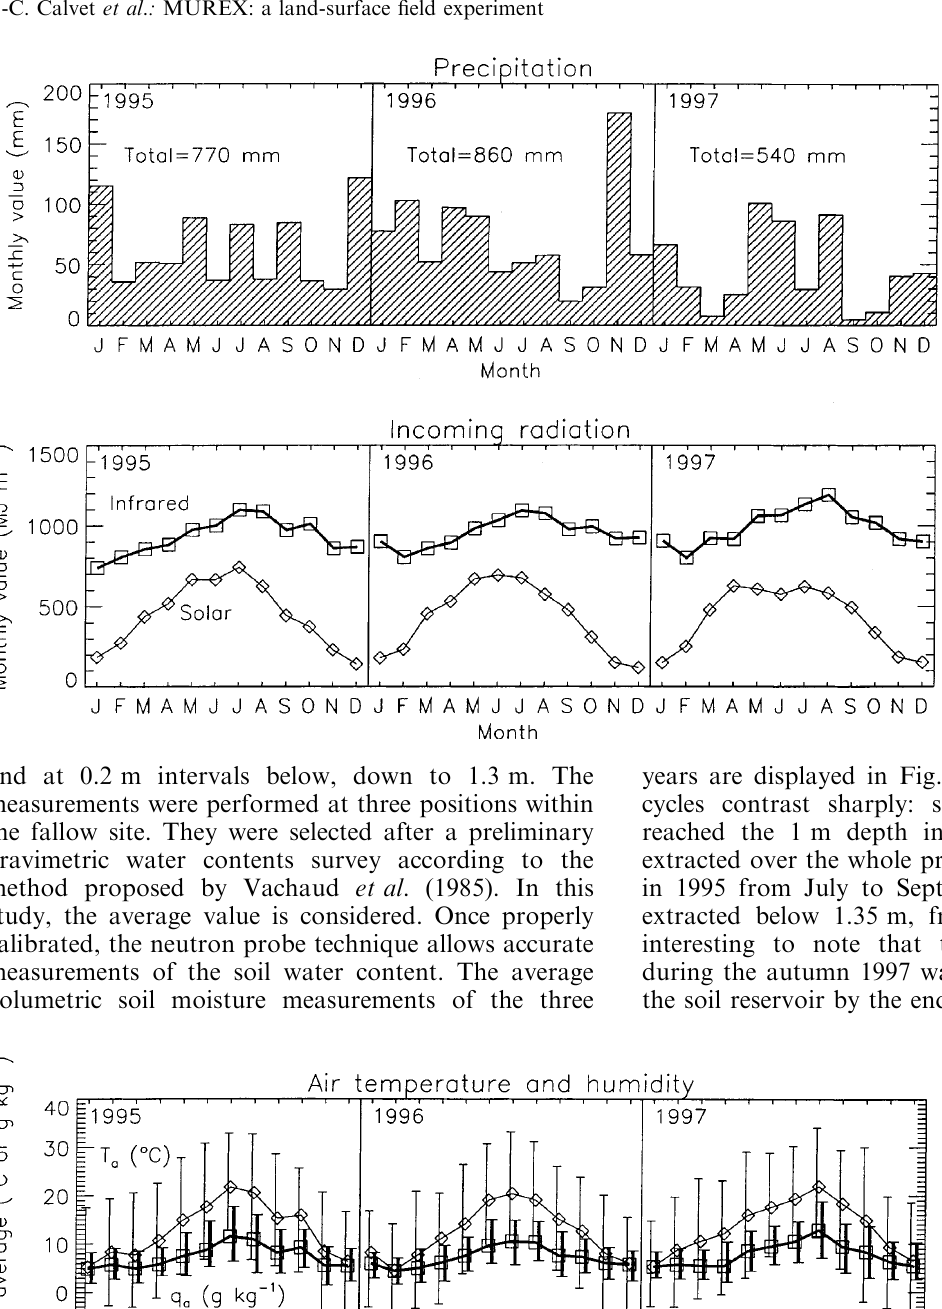
Fig. 3. As in Fig. 2, except for air temperature and humidity, T and q and wind speed. Air a a temperature, humidity, and wind speed are displayed as monthly means with maximum and minimum values indicated with bars . Air temperature and humidity are represented by diamonds with solid lines , and by boxes with solid thick lines , respectively